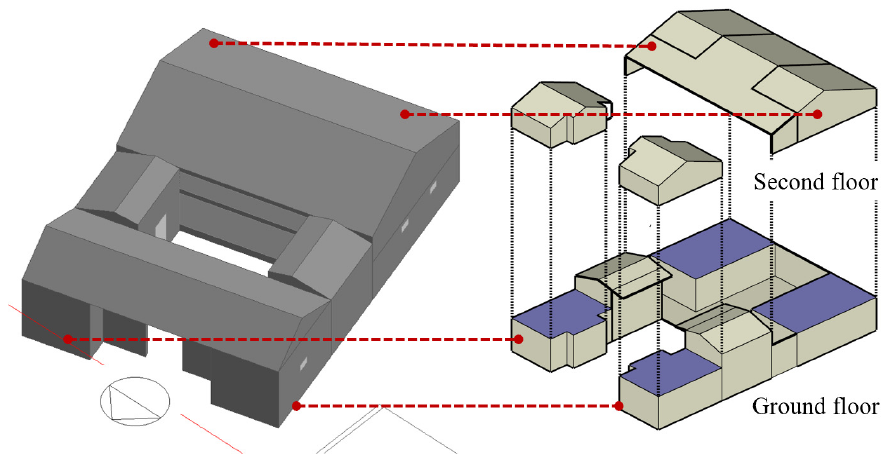
Figure 4. A 3D model of the house. Table 2. Thermophysical properties of the building envelope.